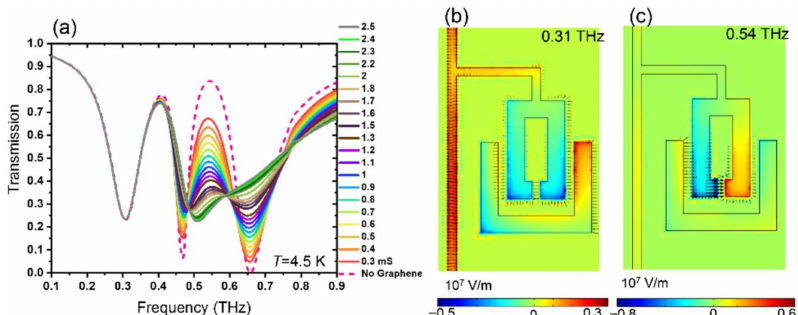
Figure 4. ( a ) Simulation transmission data for T = 4.5 K at different graphene DC conductivi- ties. Z-component of electric field distribution at σ 0 = 0 mS for ( b ) bias line resonance frequency f = 0.31 THz, and ( c ) the peak frequency f = 0.54